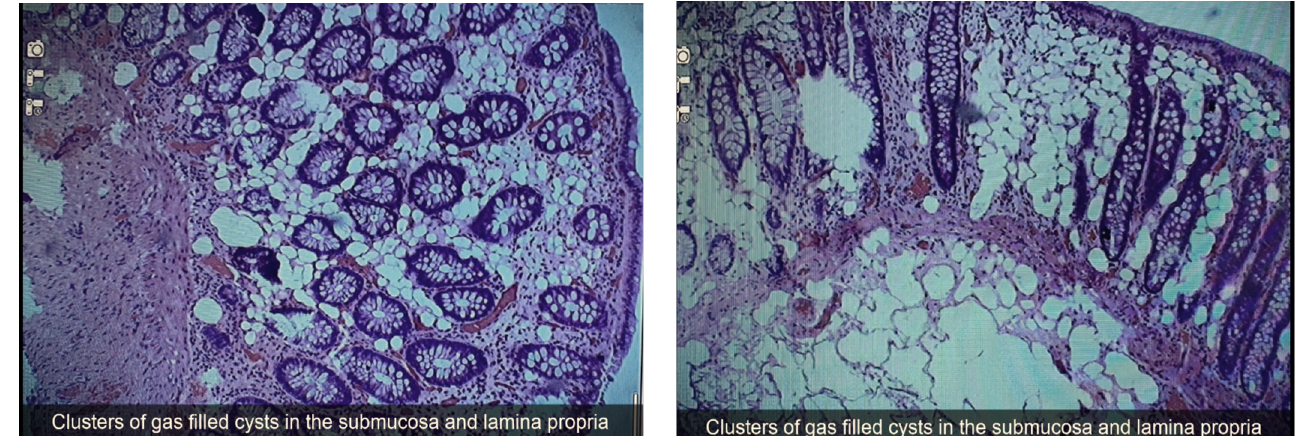
Figure 3. Biopsies of the subepithelial lesions were taken. Pathological analysis, found clusters of gas-filled cysts (as white balls) in the submucosa, and lamina propria were consistent with PCI’s diagnosis. The diverticulitis was the suspected reliable cause.